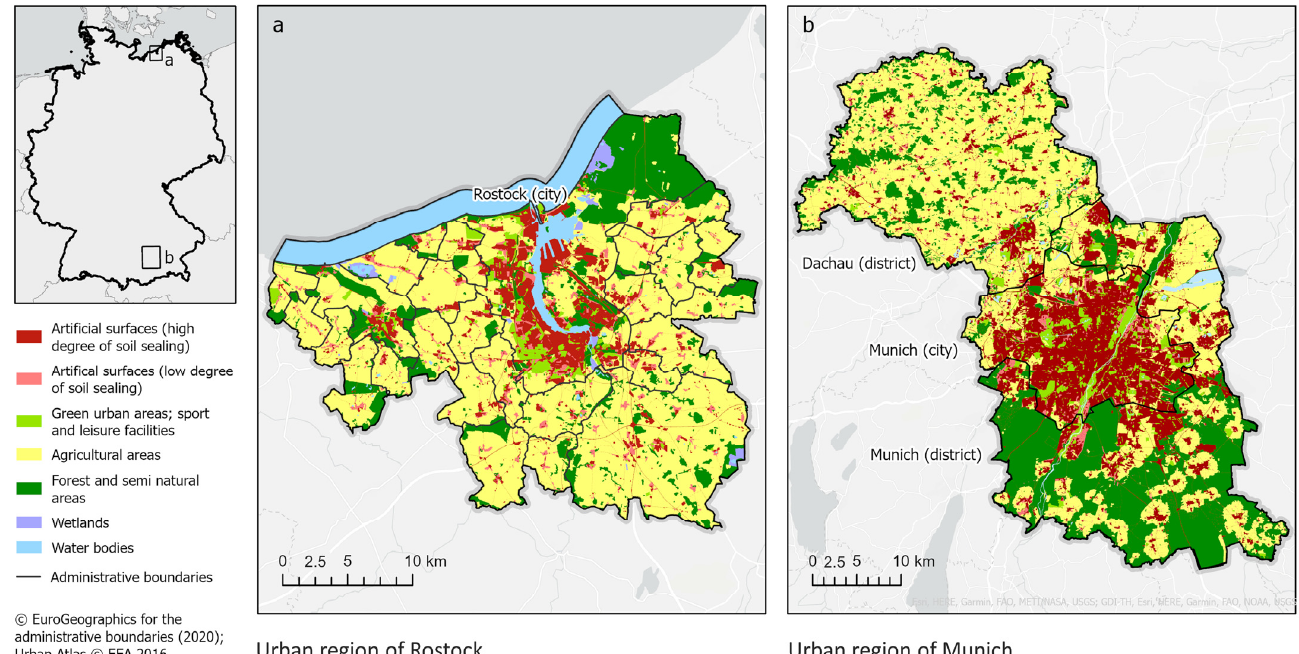
Figure 1. Location of the two urban regions of ( a ) Rostock and ( b ) Munich in Germany. Maps show the main LULC thematic classes of Urban Atlas data [44].